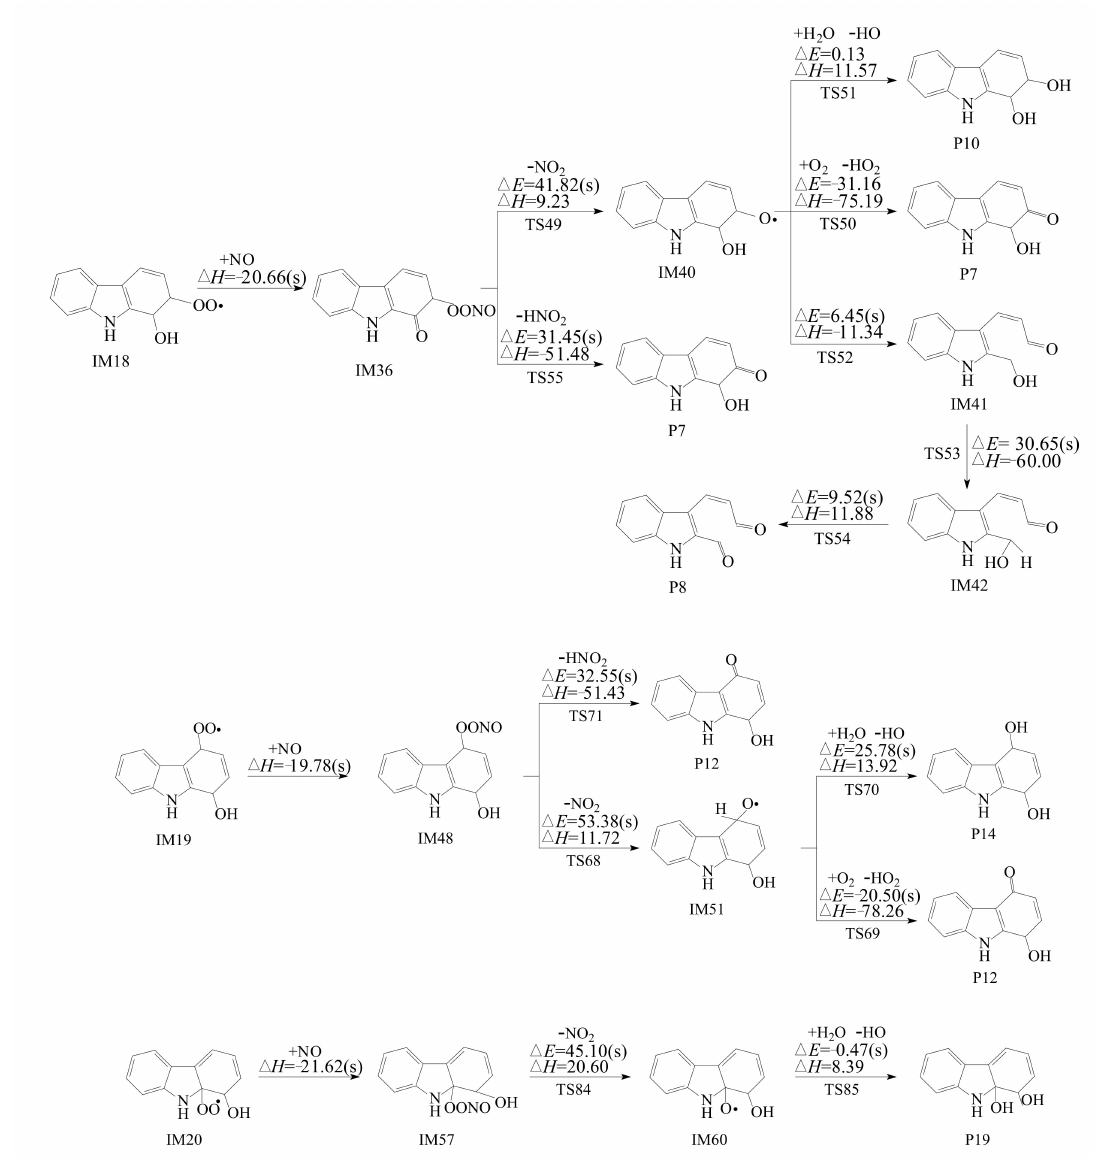
Figure 6. Intramolecular H-transfer reaction of carbazole-OH-O 2 adducts embedded with the po- tential barrier ∆ E (in kcal mol − 1 ) and reaction heat ∆ H (in kcal mol − 1 , 0 K) with and without H 2 O